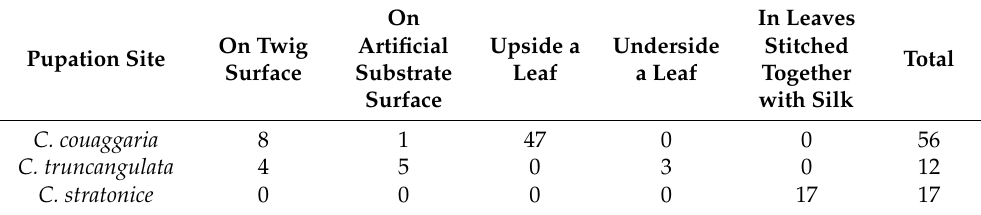
(Table 2: two-way ANOVA; developmental stage, F 3, 35 = 0.27, p = 0.85; species, F 2, 35 =